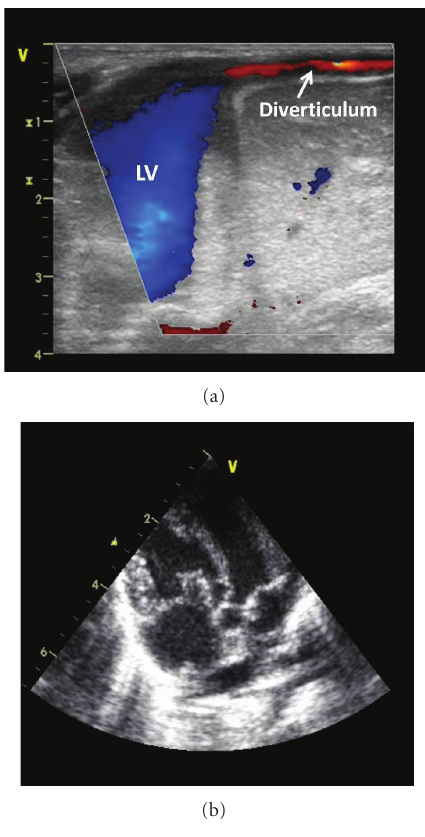
Figure 2: The echocardiography demonstrated blood flow in and out of the pulsatile mass, a left ventricle diverticulum, dextrorota- tion ofthe heart, a triatrial situs solitus, a small ventricular septal defect, and normal venous anatomy were demonstrated.